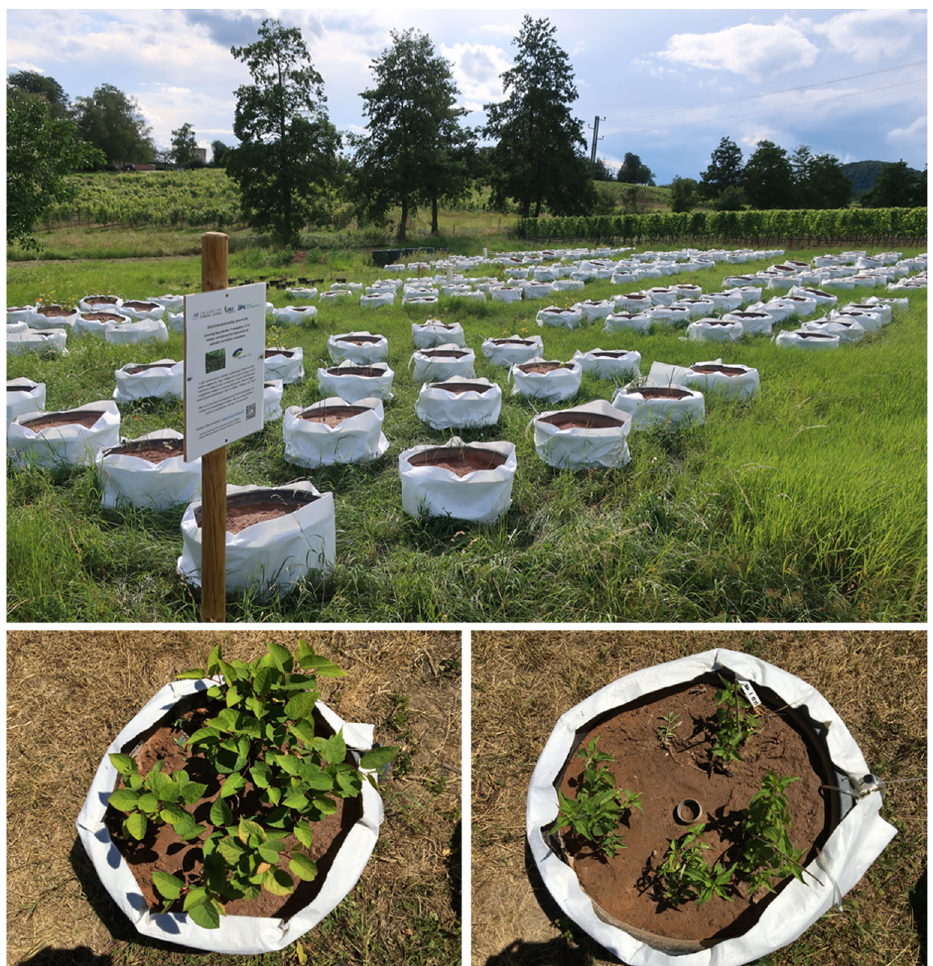
Figure 4. Experimental setup of the experiment. General view of the pots arranged in a randomized block design and sample pictures of Fallopia japonica (left) and Urtica dioica (right) growing in the pots in spring 2021.